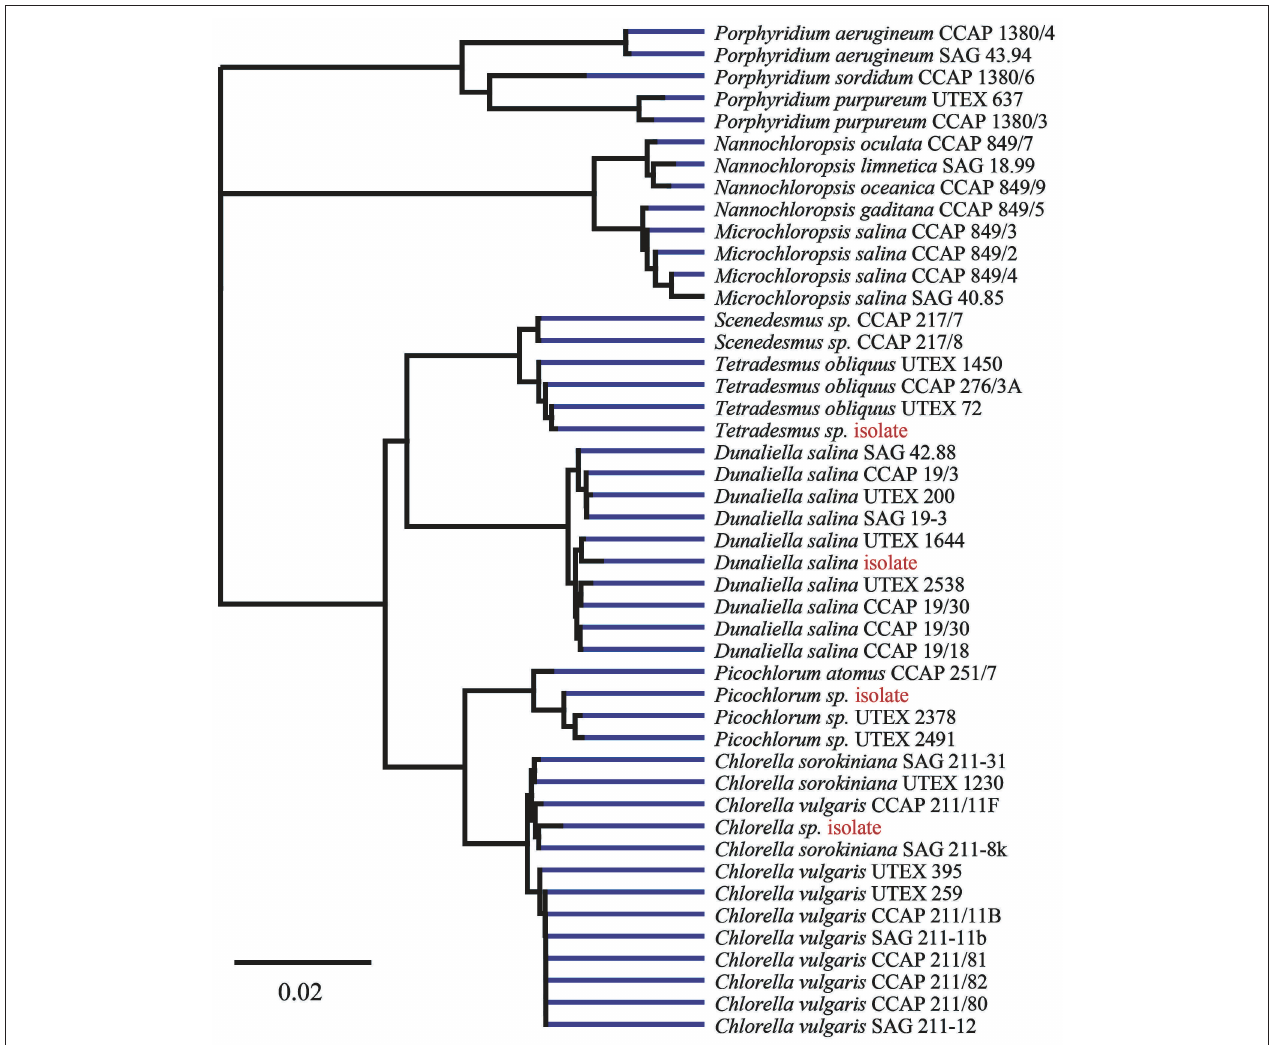
FIGURE 2 | Phylogenetic tree of isolates and reference strains 18S rDNA data build by Geneious Tree Builder [Geneious 11.1.3 (https://www.geneious.com)]. Visualization of global alignment and Neighbor-Joining with 93% similarity cost matrix using the Tamura-Nei distance model.